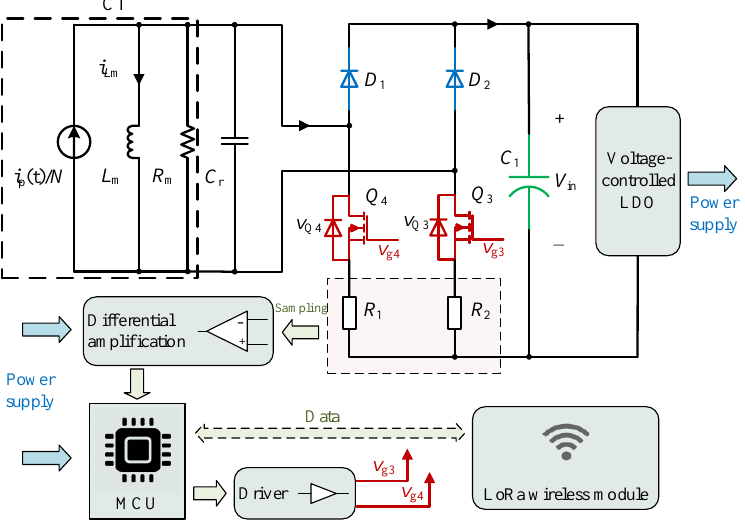
Figure 8. Detailed circuit of the time-multiplexed self-powered wireless current sensor.